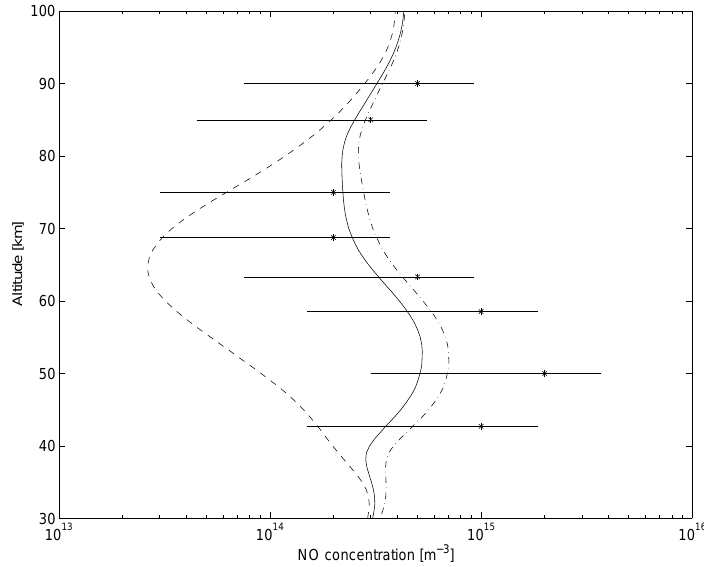
Fig. 5. NO concentration profiles. Modelling results for 18 October (dashed line) and 23 (solid line) at 10:25 UT are shown, as well as rocket data (stars) from Zadorozhny et al. (1994), including the 85% error margins. The dash-dot line shows the model result for 23 October when applying a higher production of NO by secondary electrons.